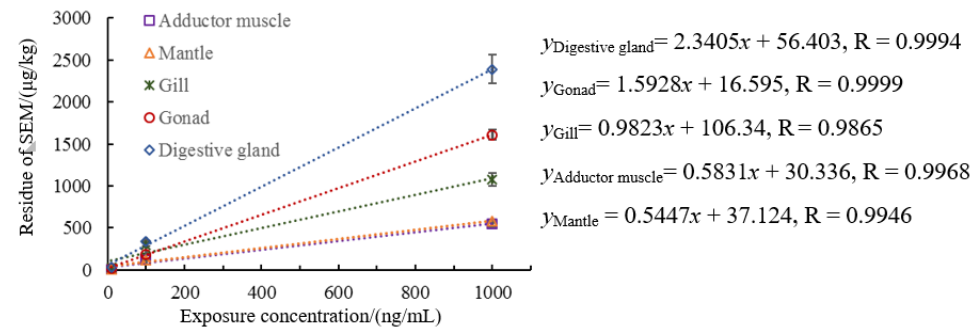
Figure 1 . Relationship between residual semicarbazide in scallops and exposure concentration. Figure 1. Relationship between residual semicarbazide in scallops and exposure